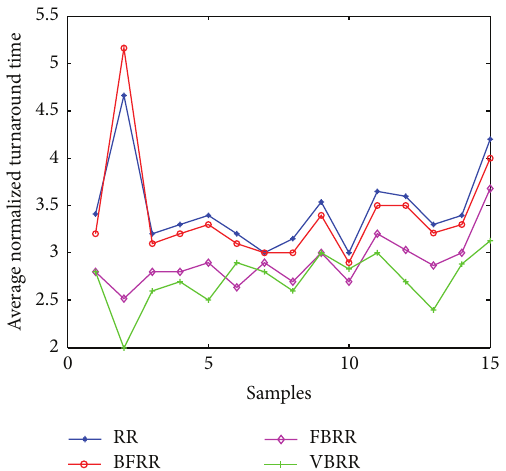
Figure 14: Average normalized turnaround time.